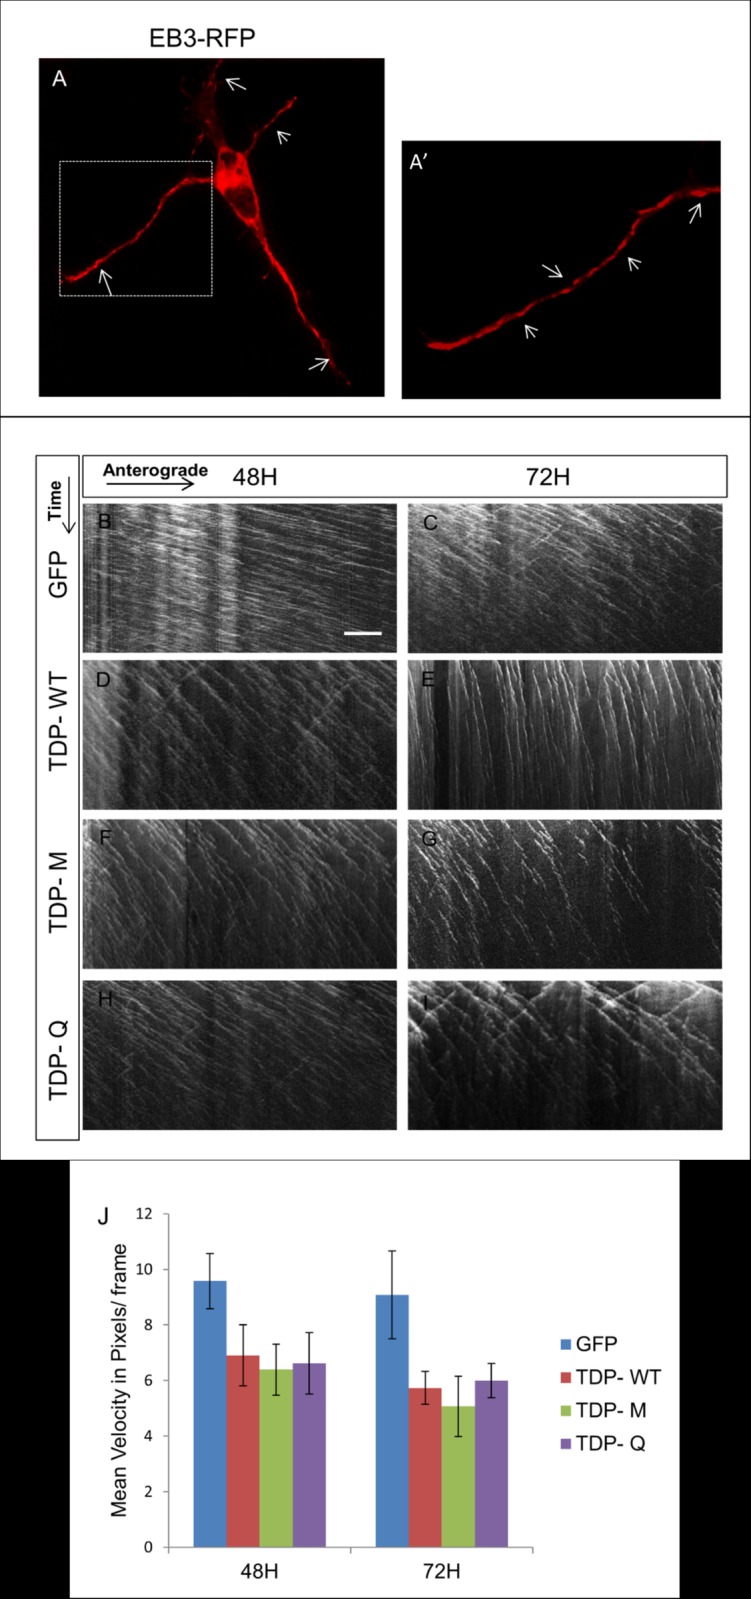
TDP-43 affects anterograde transport in cortical neurons.(A) Example of a cortical neuron co-transfected with EB3-RFP, live imaged to show EB3 ‘comets’ (arrows) (A’) Higher power view. EB3 moves in an anterograde manner towards the growing ends of axon. (B)–(I) Example kymographs of neurons expressing GFP, or co-transfected with GFP and TDP isoforms, at 48 and 72H, as labelled. Distance along the X-axis and time along the Y-axis. Scale bar = 10 µm, except in A’ (J) Quantification of the velocity of EB3-RFP comets in the axons of transfected neurons. Graphs represent means and standard error of (n = 3). No significant differences were observed.